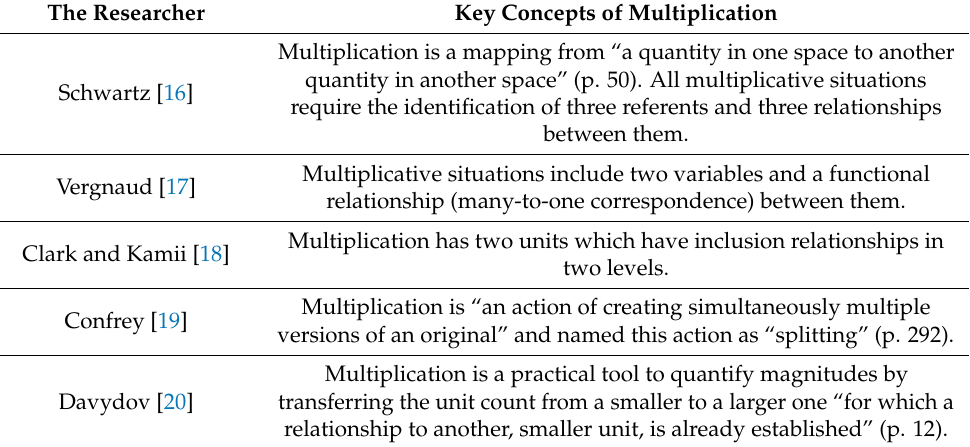
Table 1. The various meanings of